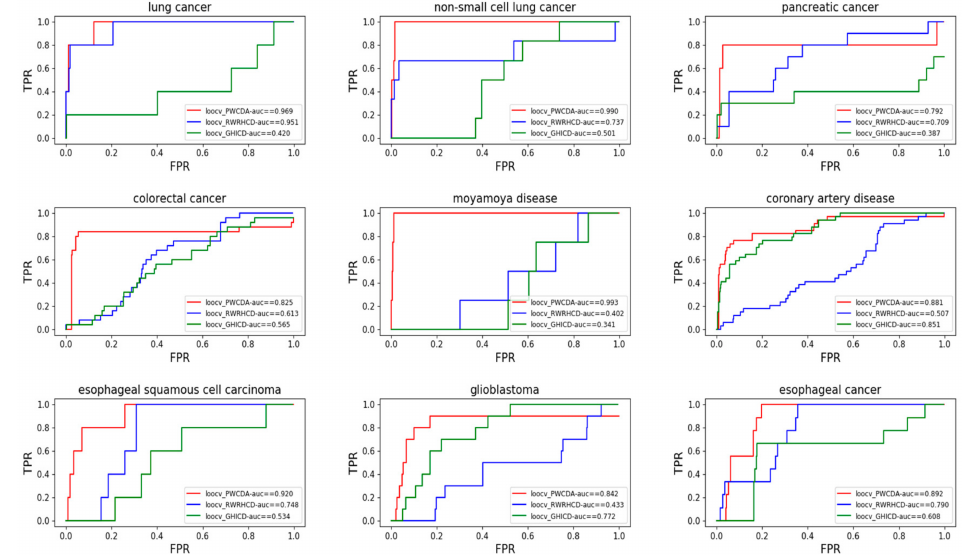
Figure 1. Comparison of Path Weighed method for predicting CircRNA-Disease Associations (PWCDA) with other models by leave one out cross validation (LOOCV). FPR, false positive